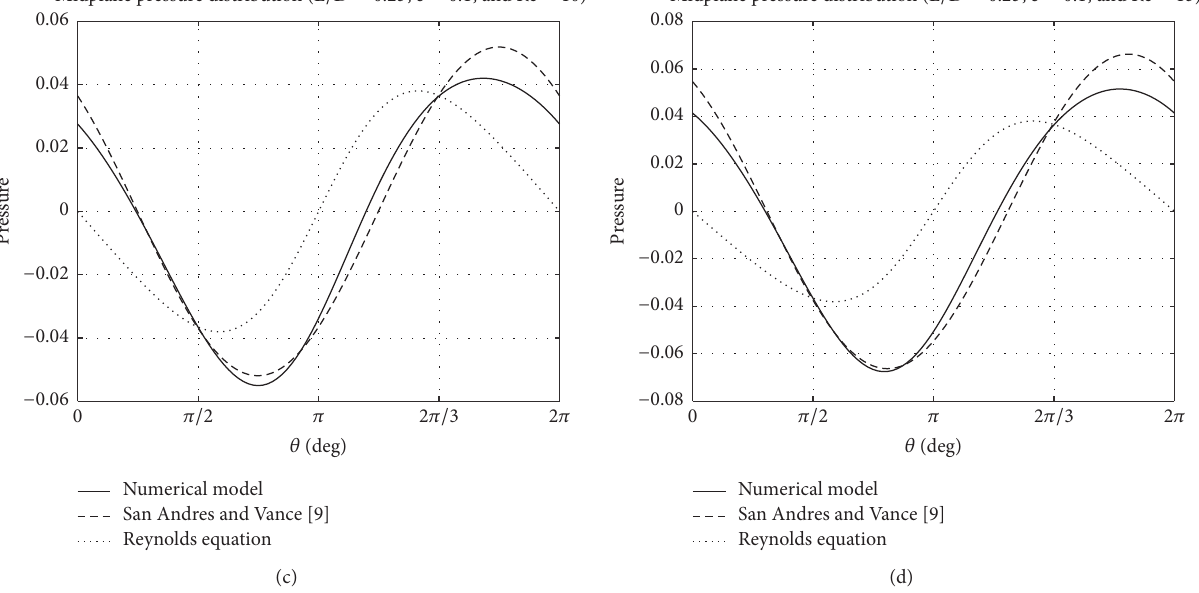
Figure 3: The effect of fluid inertia on the dimensionless pressure